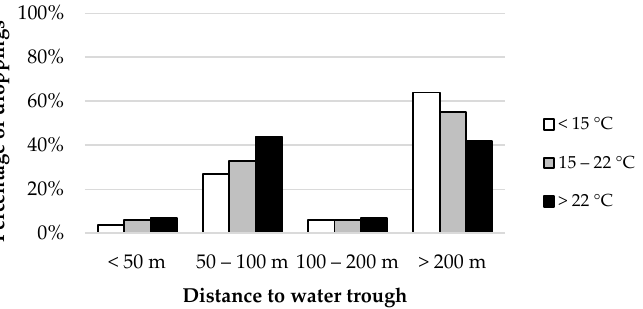
Figure 10. Effect of the interaction ambient temperature-distance to water in dung distribution.